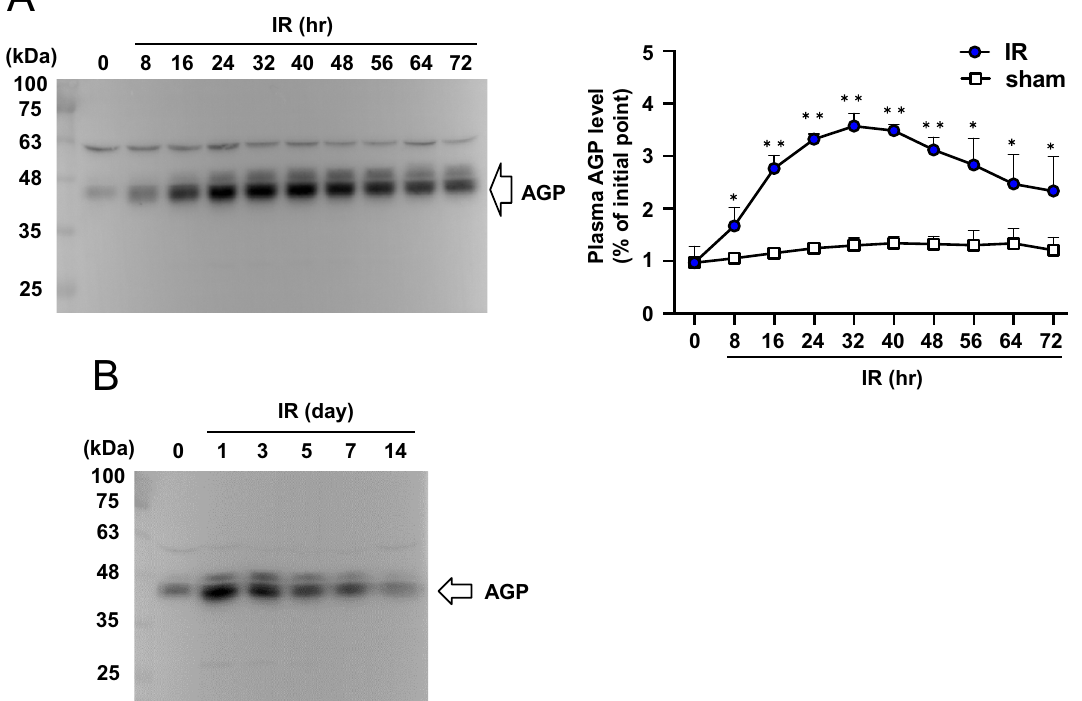
Figure 1. Plasma AGP level is increased after renal IR. Plasma AGP levels in mice before IR (0 h) and post IR (8 to 72 h), and ( B ) before IR (day 0) and post IR (day 1 to day 14) were analyzed by Western blotting using anti- AGP antibody. Data are expressed as means ± SE (n = 3). *P < 0.05, **P < 0.01 compared with sham mice at each time